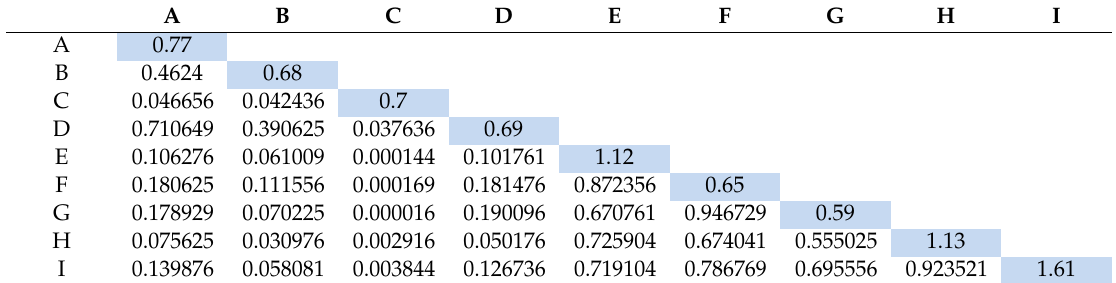
Table 4. Discriminant validity.